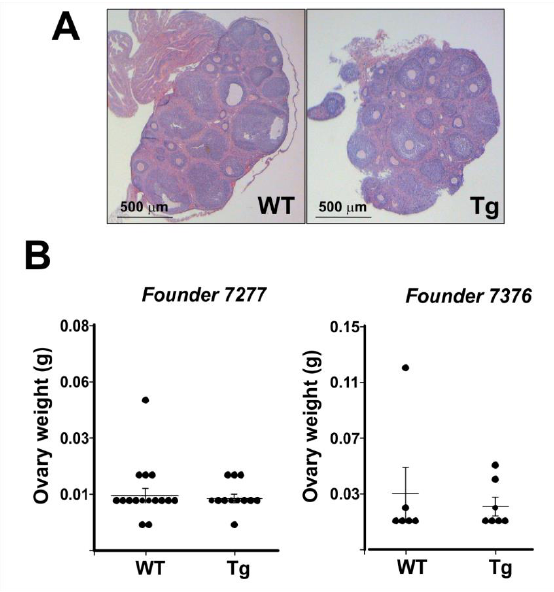
Figure 3. CMV-hDENND1A.V2 transgenic mice have morphologically normal ovaries. ( A ) Representative histological images from ovaries collected from wild-type and CMV-hDENND1A.V2 transgenic mice. ( B ) Measurements of the ovary weight from wild-type and transgenic mice for two of the founder lines. No significant differences were found in the histologic appearance and weights of PMSG/hCG-stimulated Tg and WT ovaries. For the 7277 founder, p = 0.73; for the 7376 founder; p = 0.61. WT, wild-type; Tg, transgenic.